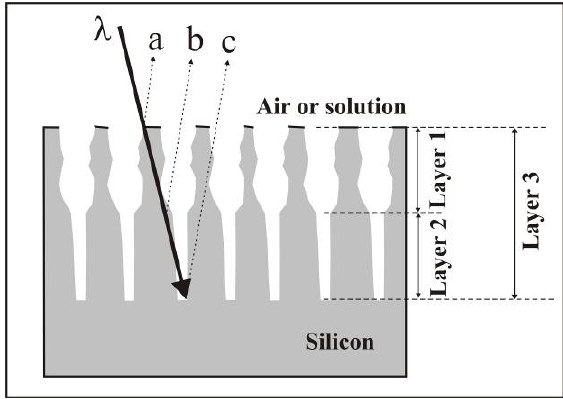
Figure 2. Scheme of a porous silicon double-layer with two different pore-diameters employed as bio-sensor which detects the molecules dependent on their size (after [48]).